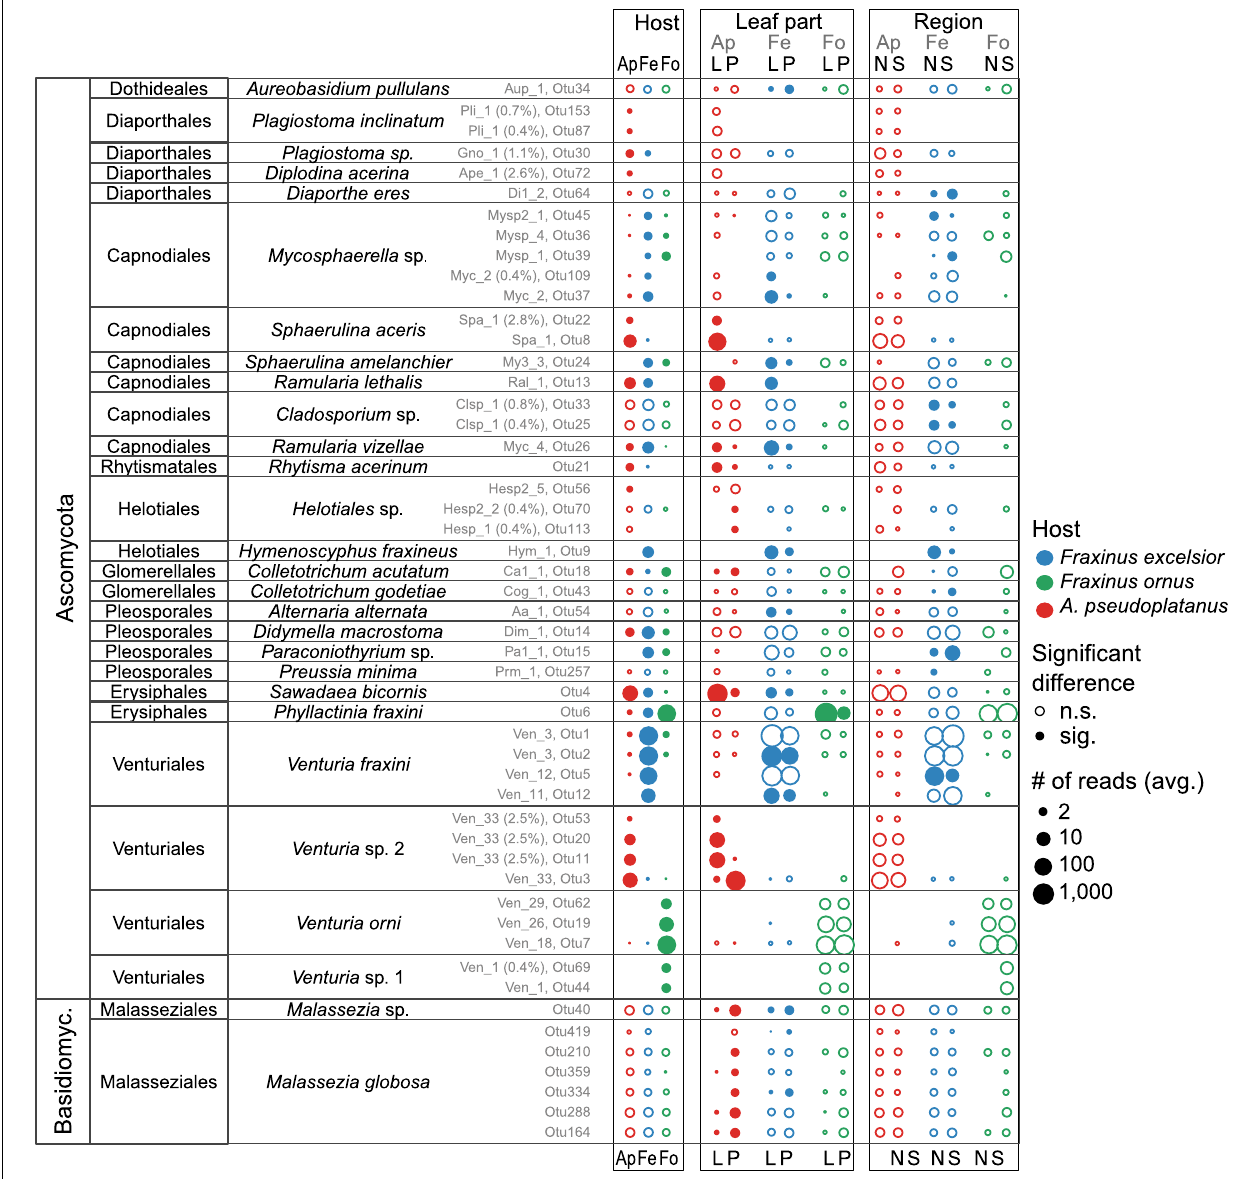
FIGURE 7 | Overview of species for which significant differences between the host species (Ap, A. pseudoplatanus ; Fe, F. excelsior ; Fo, F. ornus ), leaf parts (L, laminae; P, petioles) and/or between the north (N) and south (S) side of the Alps exist. The dots are colored according to the host species, and their size varies depending on the mean read abundances (average of sampling site averages). Potential artifacts (crosstalk) were removed before computing the averages. Filled circles indicate a significant difference for the given factor while empty circles indicate non-significant differences. Note that for the region (north/south), the significance was determined from un-adjusted p -values due to reasons described in the text. The OTU numbers are shown in gray together with the code of the cultured isolate ( Supplementary Data Sheet 2 ) if present (and % deviation of OTU from isolate sequence). For more details see also Supplementary Figures S13–S18